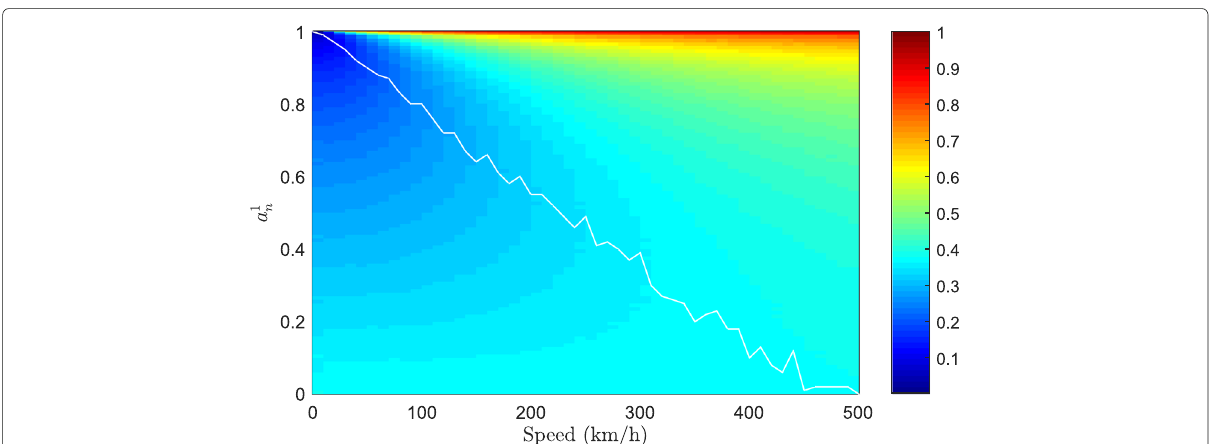
Fig. 7 MSE as a function of the autoregressive model coefficient and the speed of the UE. The coefficient with minimum MSE is marked with a white curve